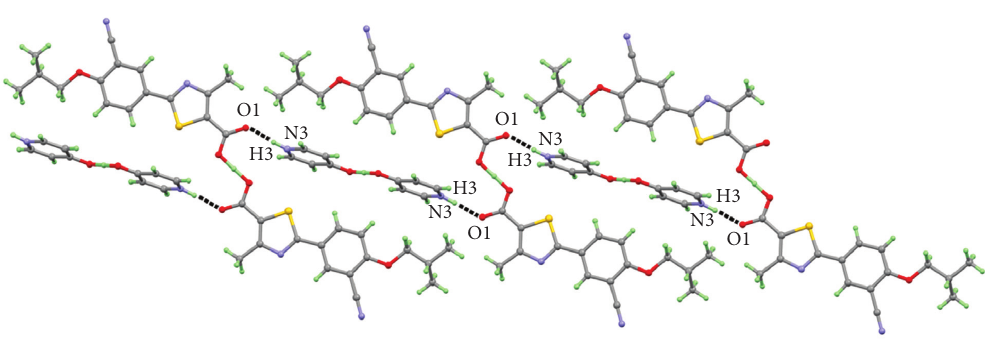
Figure 6: The crystal structures of FEB-4HP-H